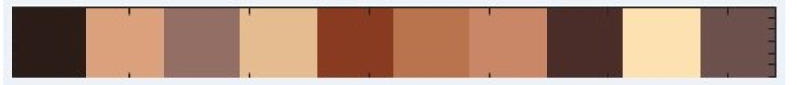
Figure 5. An example of a color palette extracted by the